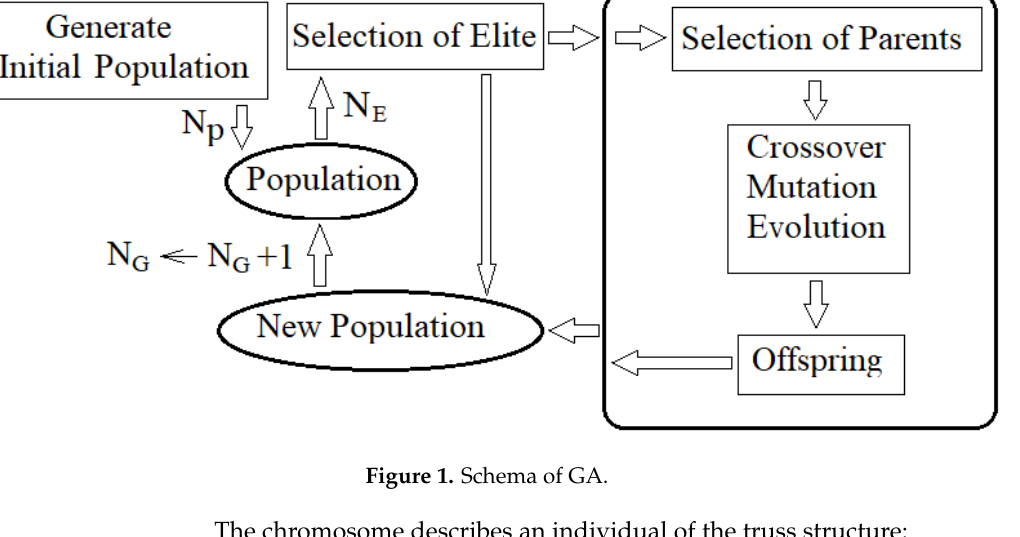
Figure 1. Schema of